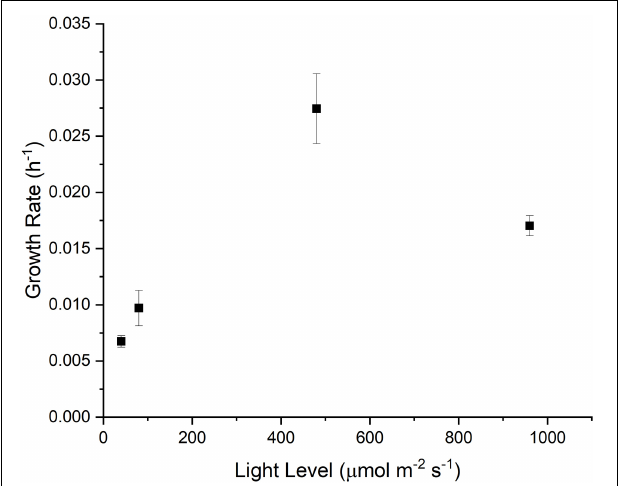
FIGURE 1 | Measured growth rates (h − 1 ) as a function of light level ( µ mol m − 2 s − 1